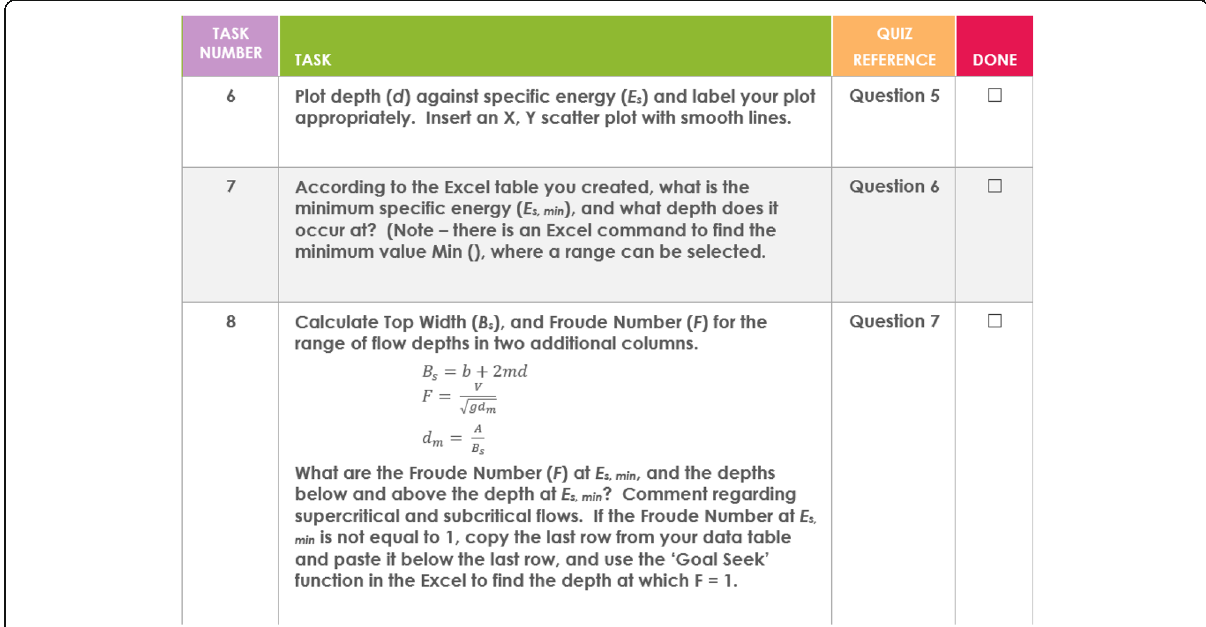
Fig. 2 Downloadable instruction sheet with reference to the Moodle